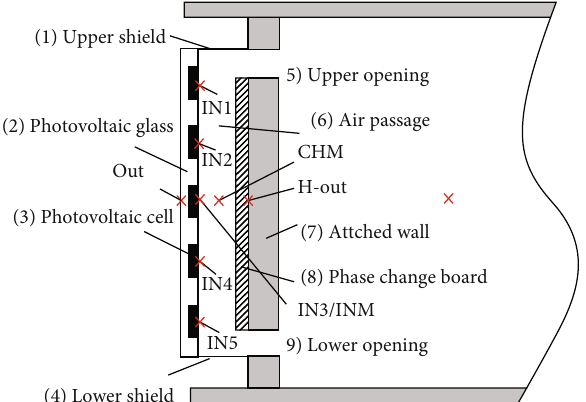
Figure 1: Schematic of structural principle of PV-PCM-Trombe wall system and the arrangement diagram of thermocouples.